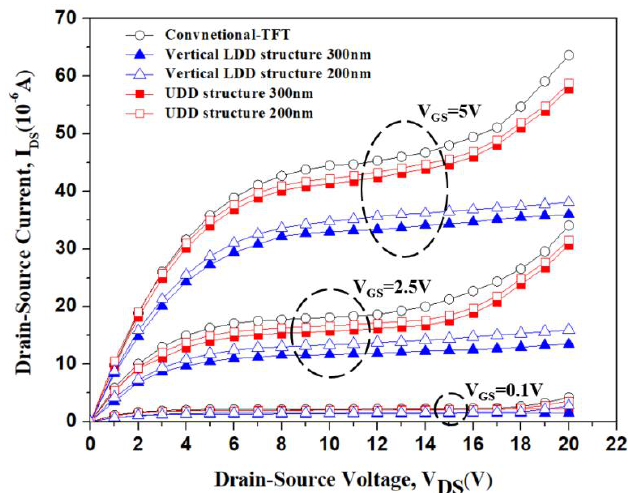
Figure 8. I DS -V DS characteristic curves of conventional TFT and type C devices with vertical LDD and UDD.